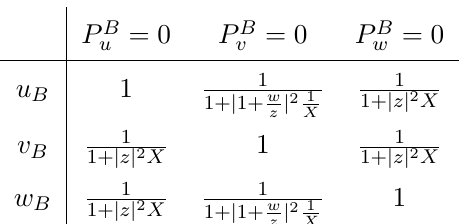
Table 2 . Behaviour of the cross ratios in the NMRK at the three unphysical-singularity surfaces of the rational terms of the ordering σ , listed in eq. B